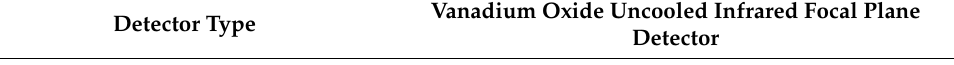
Table 1. Parameters of commercial thermal camera.